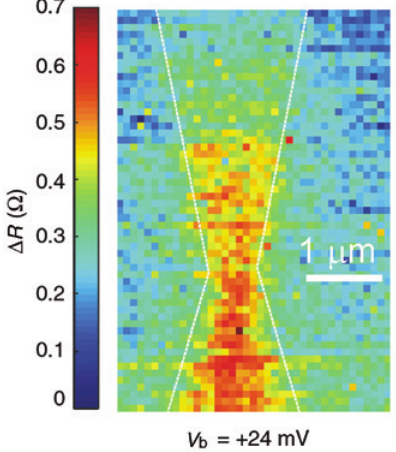
Figure 5: Map of the constriction resistance Δ R ( x , y ) when the structure is scanned through the focus for V